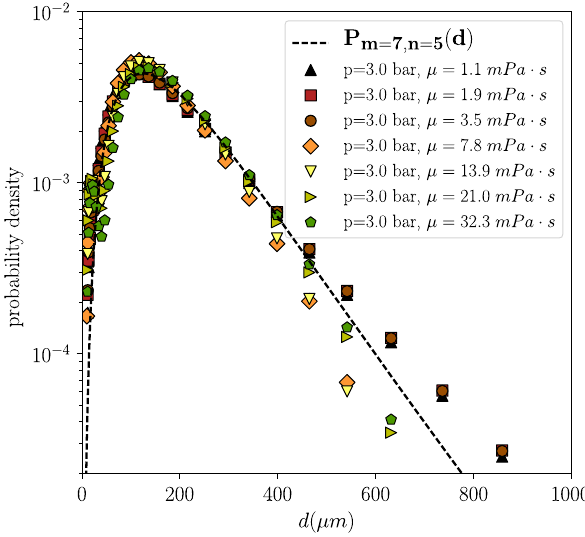
FIG. 3. A log-log plot of D 50 divided by the effective nozzle area against the flow rate for all nozzles. The fit line has a slope of − 2 = 3 . FIG. 4. Droplet size distribution of water-glycerol mixtures, with viscosities ranging from μ ¼ 32 . 3 to 1 . 1 mPa · s (Teejet 110-03). For this range of viscosities, there is no significant change in the size